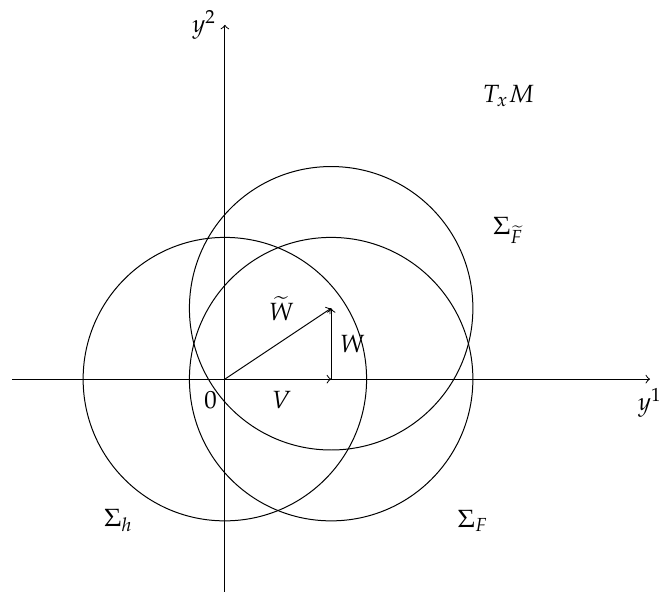
Figure 3. The h -indicatrix, F 1 -indicatrix and F